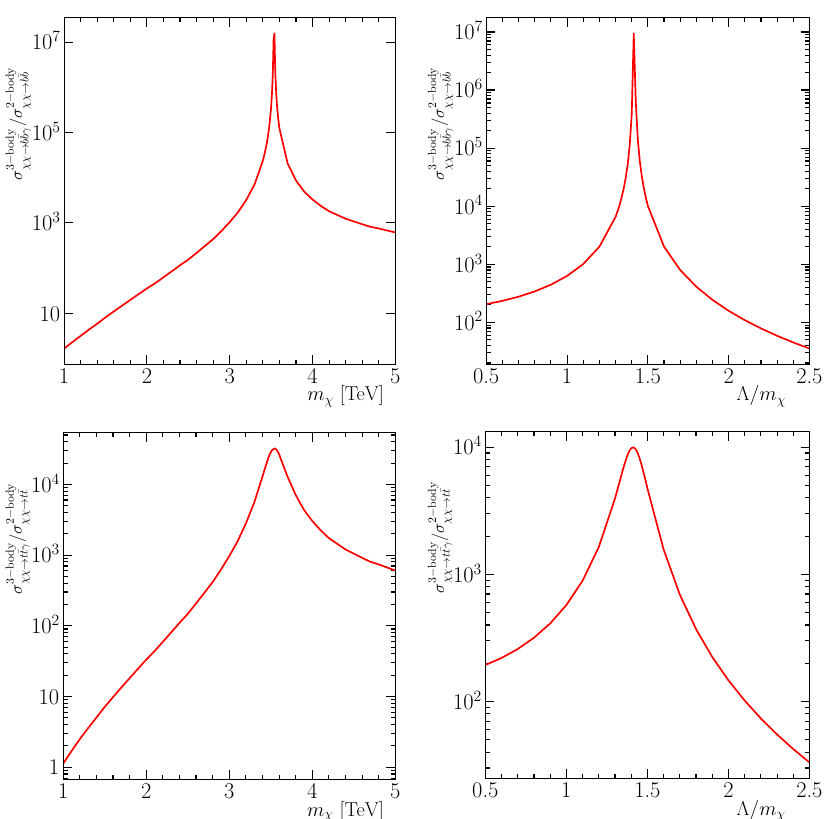
Figure 2 . ( 1 st column: ) Ratio of 3-body cross section ( (cid:31)(cid:31) ! b (cid:22) b(cid:13) ) to the 2-body cross section ( (cid:31)(cid:31) ! b (cid:22) b ) as a function of the dark matter mass, m (cid:31) (left), and as a function of the ratio of the EFT scale to the dark matter mass, (cid:3) =m (cid:31) (right). In the left panel we set (cid:3) = 5 TeV and in the right panel we set m (cid:31) = 2 TeV. We set d 6 = 1, d 8 = 1, v = 10 (cid:0) 3 c for both these plots. ( 2 nd column: ) The same for the (cid:12)nal state comprising of top